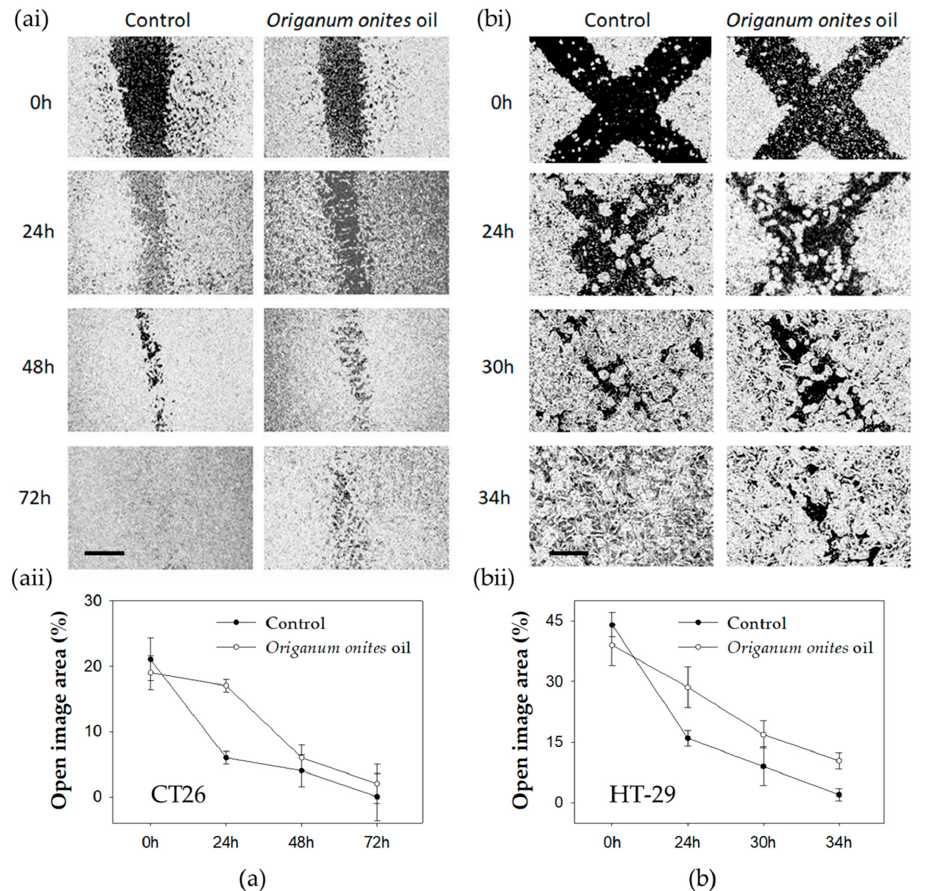
Figure 3. Effect of OOEO on migration of colon cancer cells. Wound-healing assay for ( a ) CT26 and ( b ) HT-29 cells treated with the oil (0.70 µ g / mL for CT26 and 0.50 µ g / mL for HT-29 cells) or dimethylsulfoxide (DMSO) for control. Migration of ( ai ) CT26 (scale bar = 500 µ m) and ( bi ) HT-29 cells (scale bar = 300 µ m) was monitored with an optical microscope equipped with a digital camera at the indicated time points. Quantification of the percentage of wound closure was estimated by ImageJ software analysis for ( aii ) CT26 and ( bii ) HT-29 cells. Data are presented as the mean ± SD of three independent experiments.